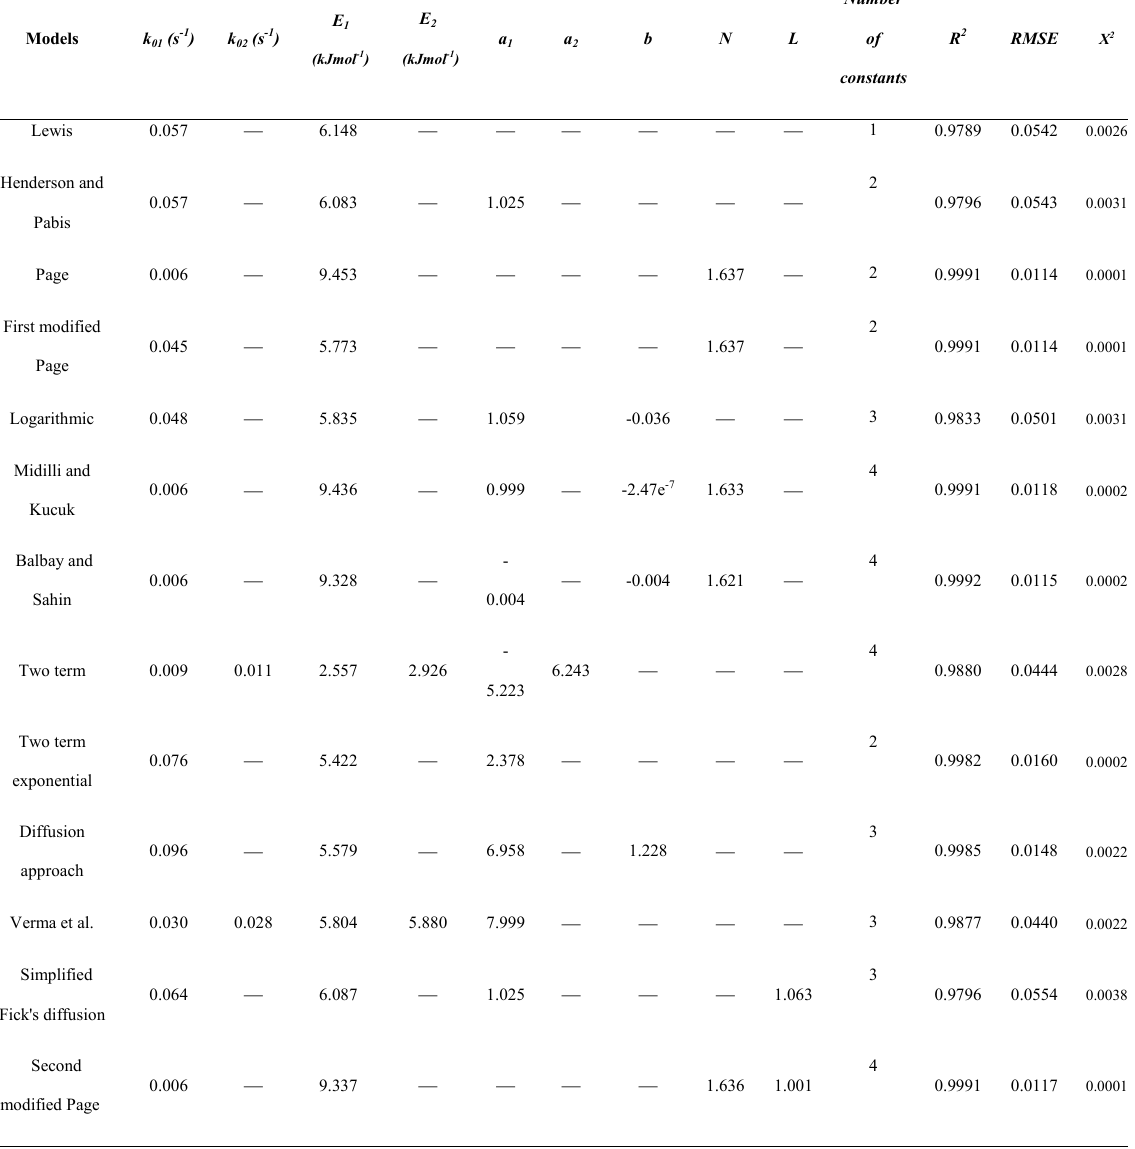
a.The fitted coefficient can be used in the correlation with time in second